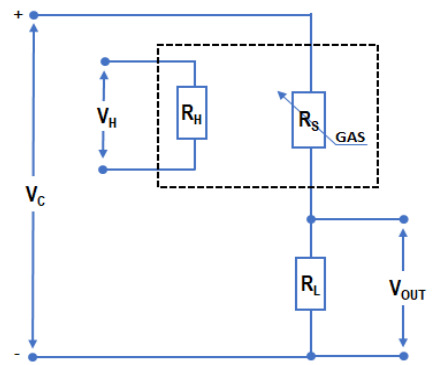
Figure 1. The scheme of the measuring system of the TGS2610-C sensor, where R S —sensor resistance; R L —resistance of an auxiliary (load) resistor; V C and V H —voltage of sensor circuit and micro-heater circuit; V OUT —voltage related to sensor resistance R S measured in a voltage divider system using an auxiliary resistor R L .